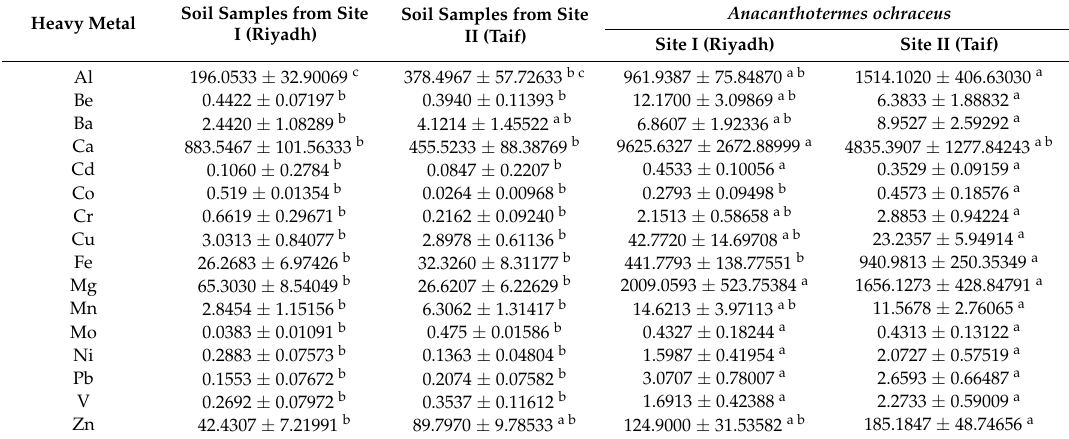
Table 2. Heavy metal concentrations (mg/g dry weight) in two different habitats and tissues of A. ochraceus .